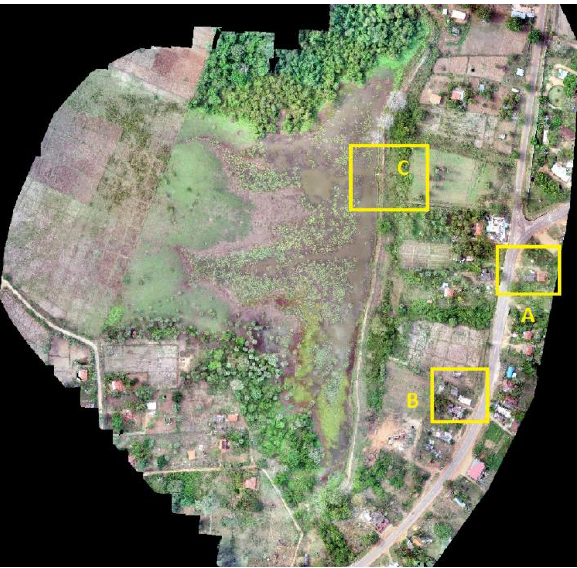
Since the objective is to assess the accuracy of stitched image, for the accuracy analysis, it is used only the surveyed checkpoints falls within the land plot A, B and C. Besides, to assess the accuracy of the outside the stitched areas, corresponding checkpoints falls outside to the plot A, B, and C are used. Both ± errors (see figure 7) indicates that there is no bias in the measurements and the product. Further to that, RMSE of the topographic features that falls within the land plot A, B and C are also computed.